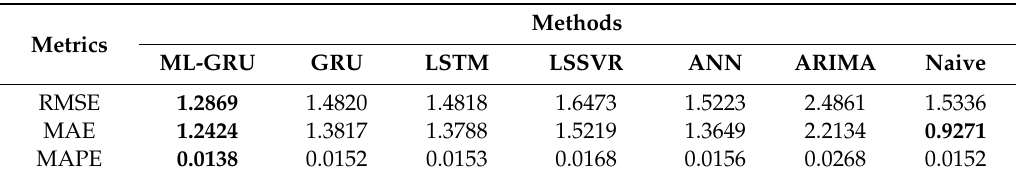
Table 3. Predictive performance comparison of single